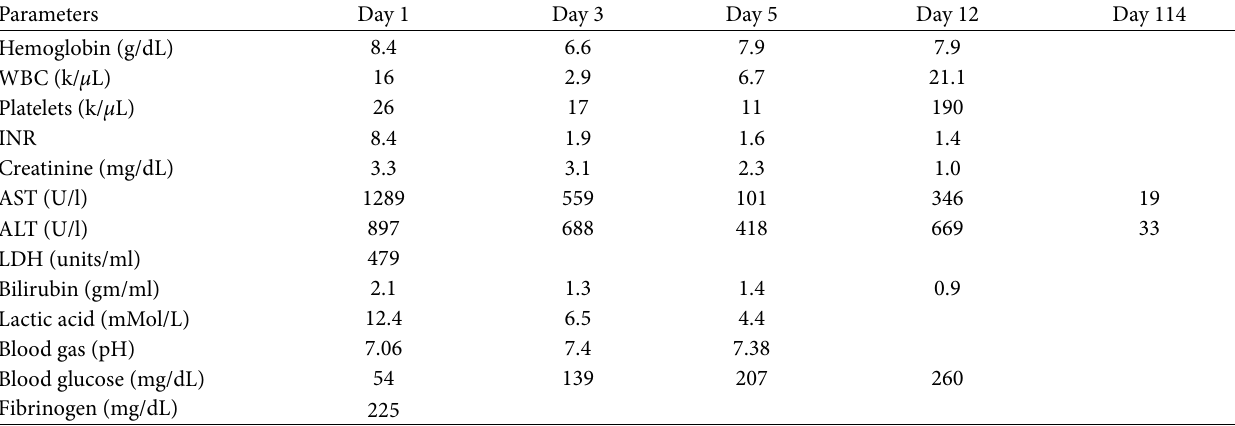
Table 1: Demonstrates laboratory parameters at the time of admission and the improvement after discontinuation of linezolid.